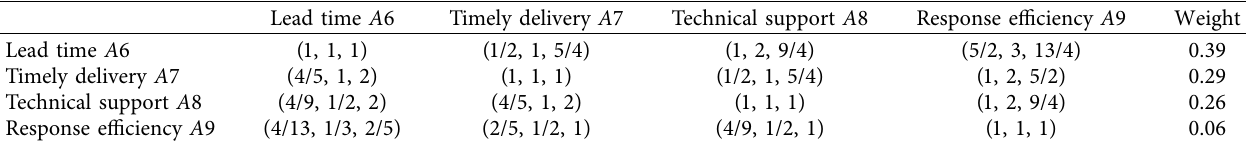
Table 5: Fuzzy judgment matrix of supplier service quality.